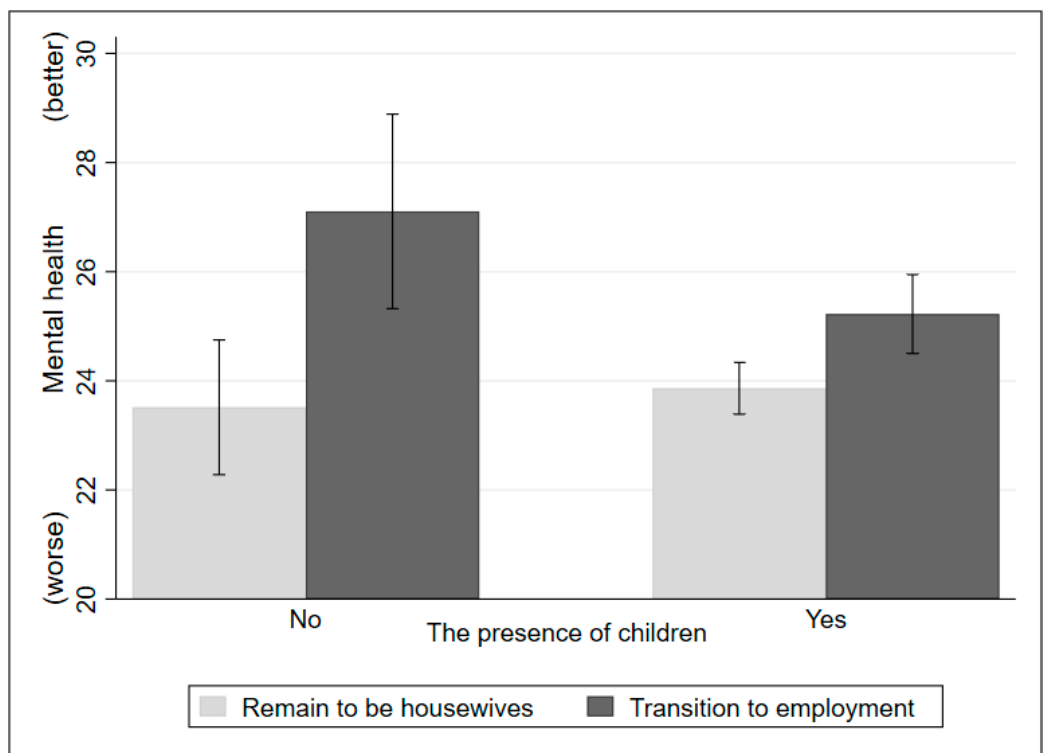
Figure 2. The moderation effects of the presence of children in the impacts of job status transition (total sample).